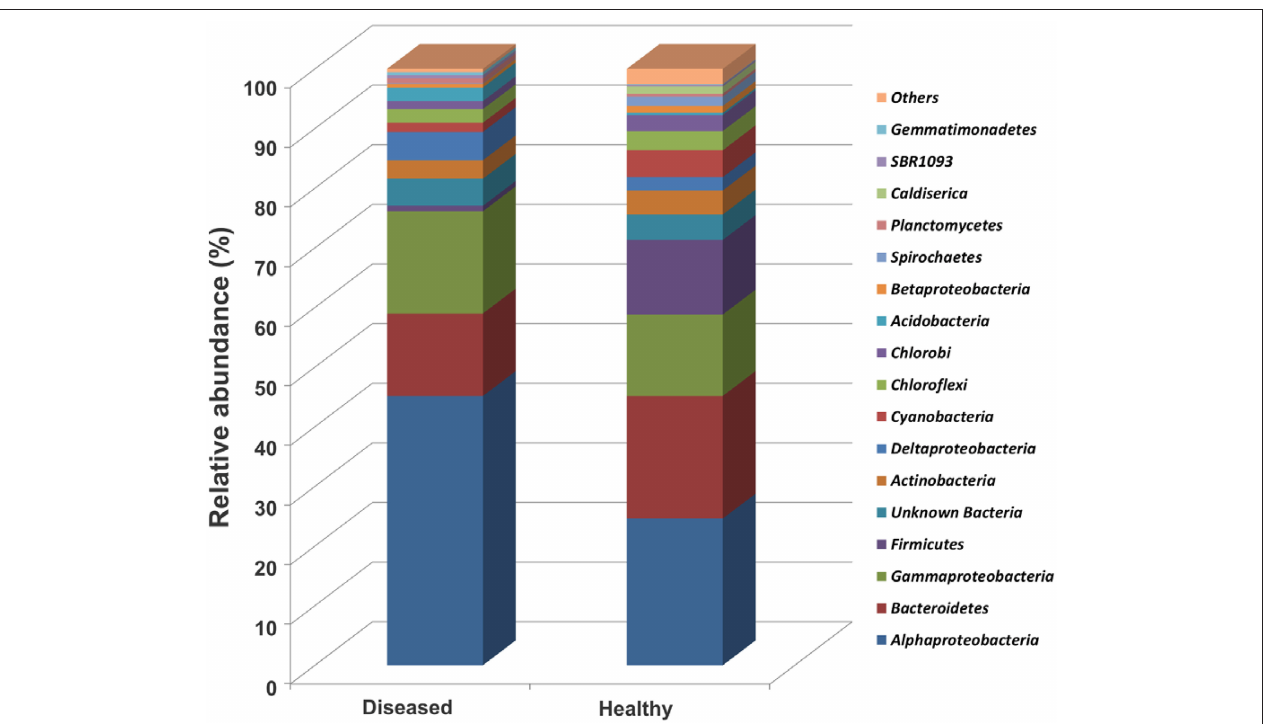
FIGURE 3 | Relative abundance (%) of major bacterial phyla (except Proteobacteria into class) in sequenced OTUs from the apparently healthy and the diseased tissue samples. Healthy, apparently healthy tissues of SGA affected P. carnosus colonies; Diseased, diseased tissues of SGA affected colonies. Stacked bars were calculated from the mean of relative sequence abundance belonging to each phylum in each sample